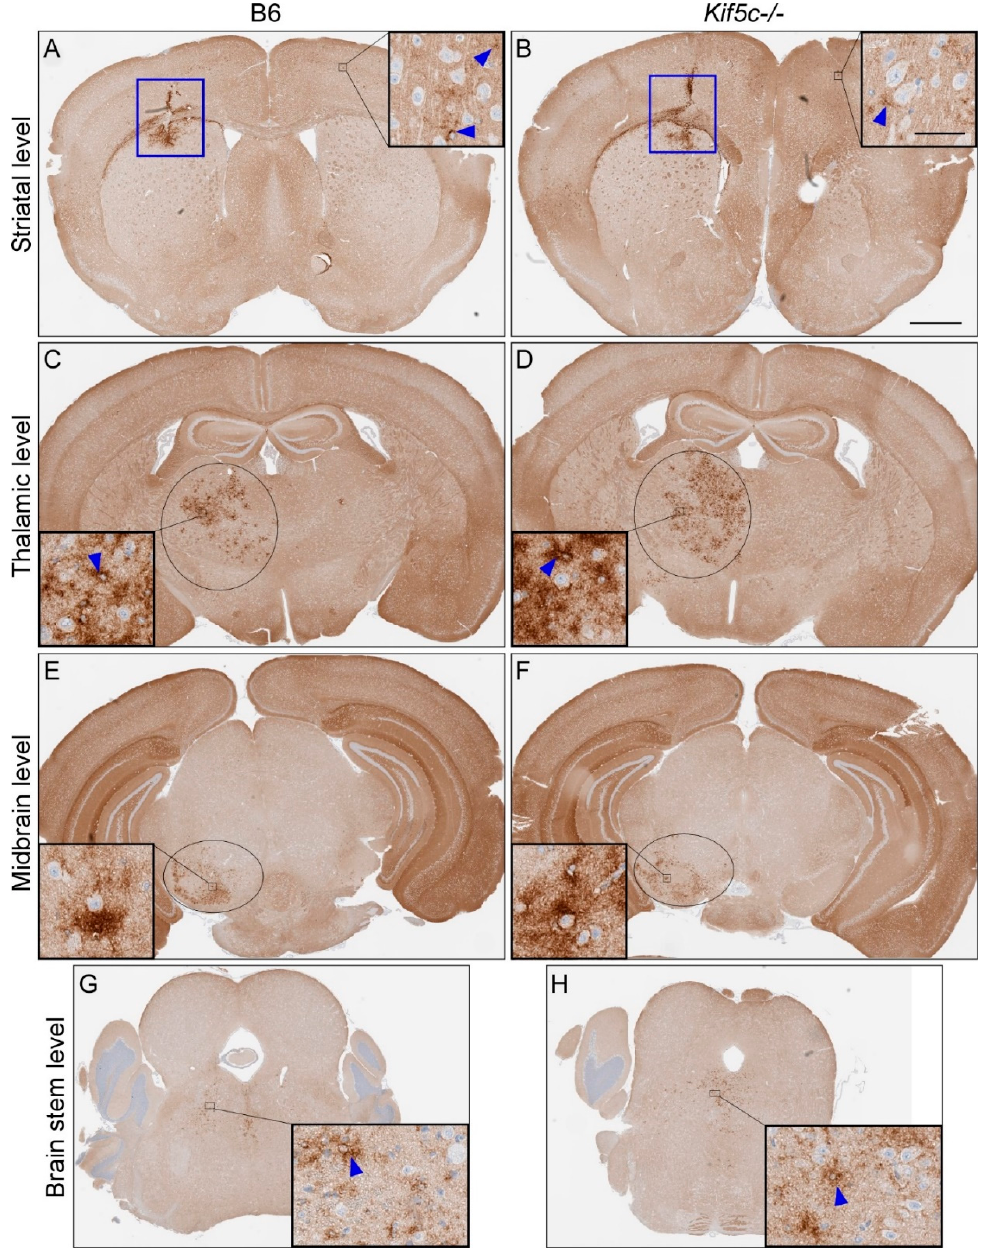
Figure 4. PrPSc staining of mouse brains 40 days post 22 L scrapie inoculation. IHC using anti-PrP antibody D13 was performed on coronal sections from four areas. A representative B6 mouse is shown on the left side, and a Kif5c − / − mouse on the right. ( A , B ) Coronal sections including the striatum. The nt is depicted with a blue box. The insets show higher magnification of the cerebral cortex with subtle PrPSc staining (blue arrowheads). ( C , D ) Coronal sections through the thalamus. The black oval depicts the approximate borders of the thalamus and the high magnification insets show focal PrPSc staining. ( E , F ) Midbrain sections including the substantia nigra (black ovals). Insets show higher magnification and PrPSc present in the substantia nigra. ( G , H ) Rostral pons sections and higher magnification insets showing PrPSc. The scale bar in B is 1 mm and applies to all the large panels. The scale bar in the inset within panel B is 50 µm and applies to all the insets.